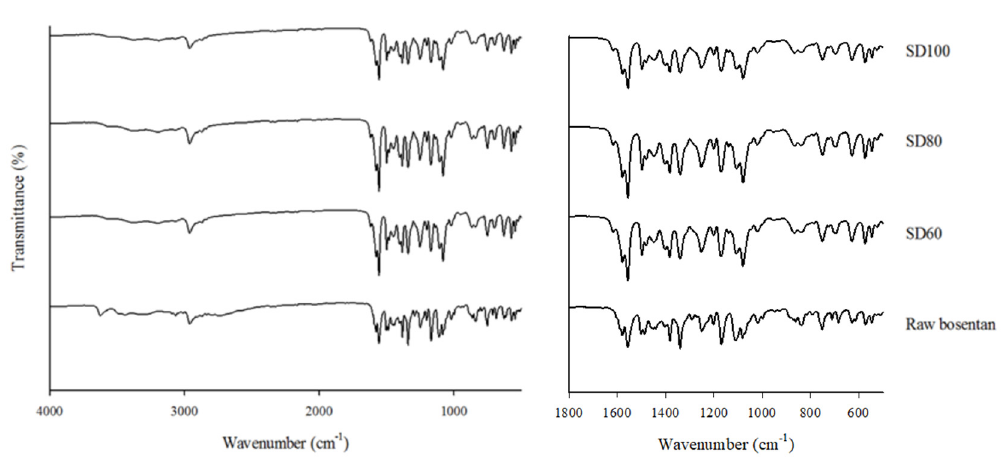
Figure 4. FT-IR spectra of spray-dried bosentan microparticles and raw bosentan.